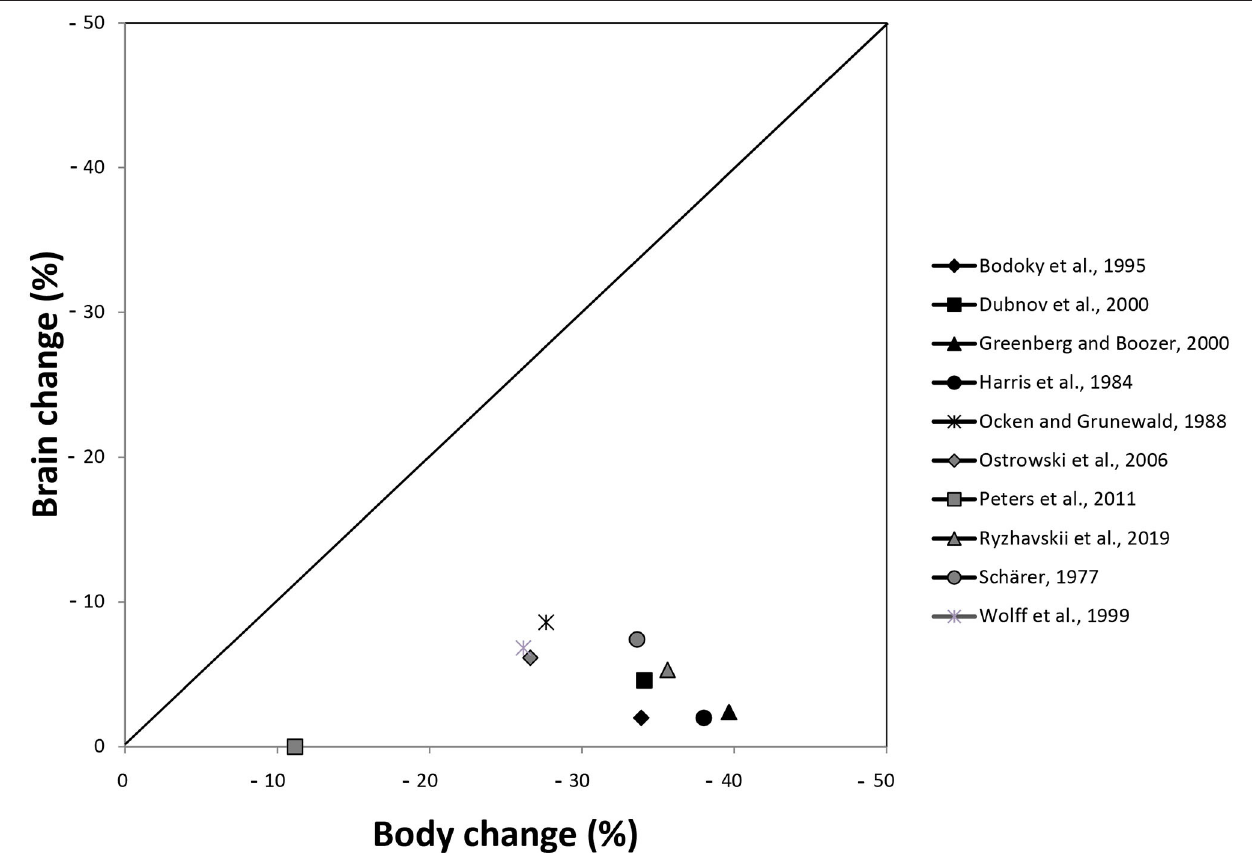
FIGURE 3 | Presentation of percentage changes in brain and body outcomes extracted from Table 1 . Harris et al. (1984) conducted their experiment in females and males; here, the data of males are presented. Schärer (1977) conducted three experiments; here, the data of experiment 1 are shown.